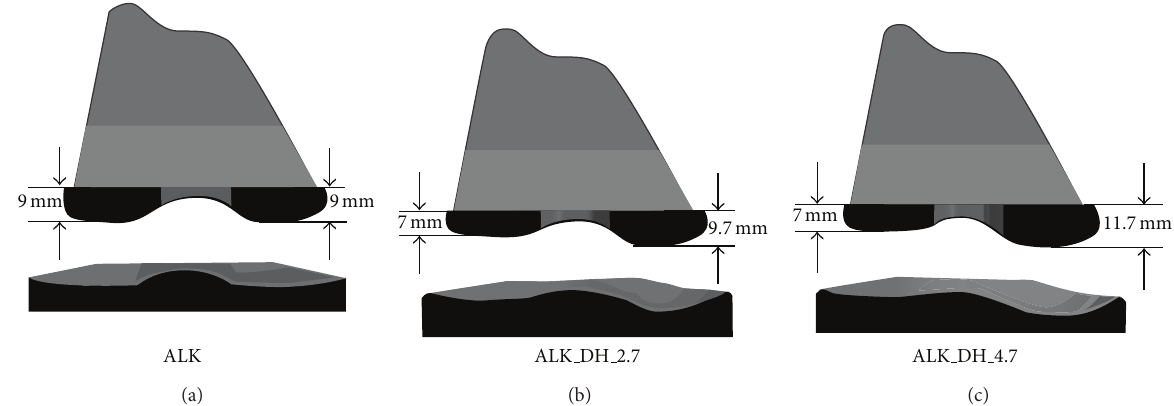
Figure 1: Femoral and tibial components modified on both medial and lateral sides [18]. (a) Anatomic-like knee, (b) knee with condyle height difference of 2.7 mm, and (c) knee with condyle height difference of 4.7 mm.